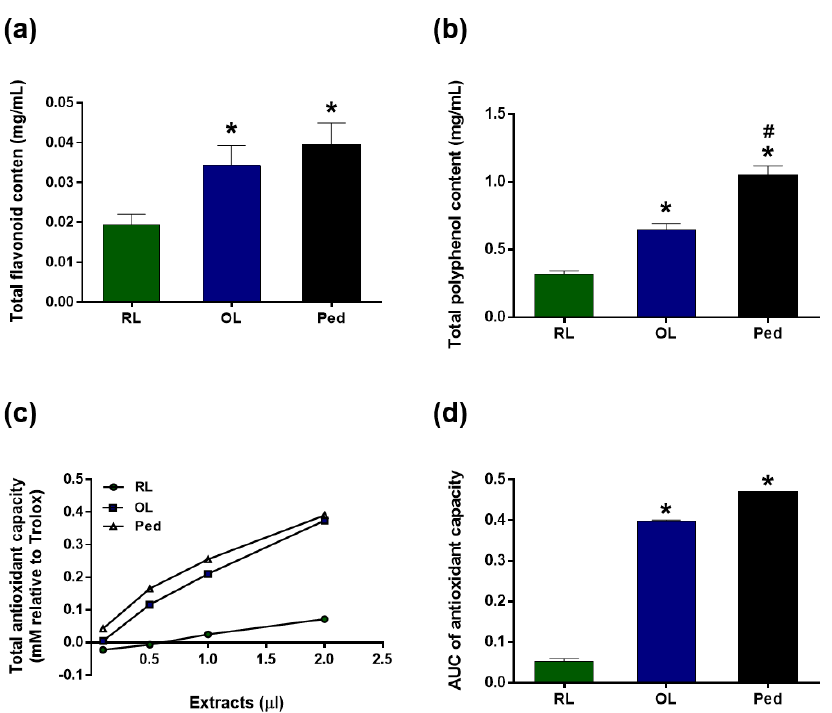
Figure 1. Antioxidant content of raw leaves (RL), oxidation-treated leaves (OL), and peduncles (Ped). Total flavonoid content ( a ) and polyphenol content ( b ). Total antioxidant capacity was measured via the ABTS assay ( c ), and the AUC is represented ( d ). Data are presented as the means ± SEM. * p < 0.05 versus RL; # p < 0.05 versus OL.